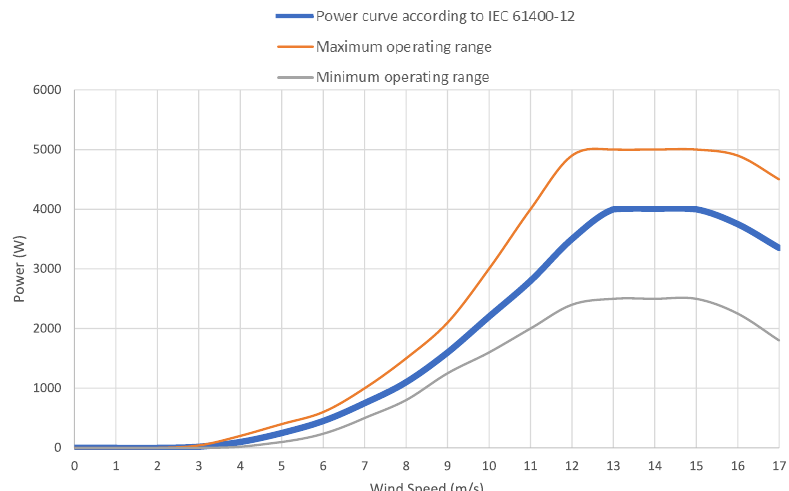
Figure 5. Power curve of the Anelion SW 3.5 GT wind turbine.